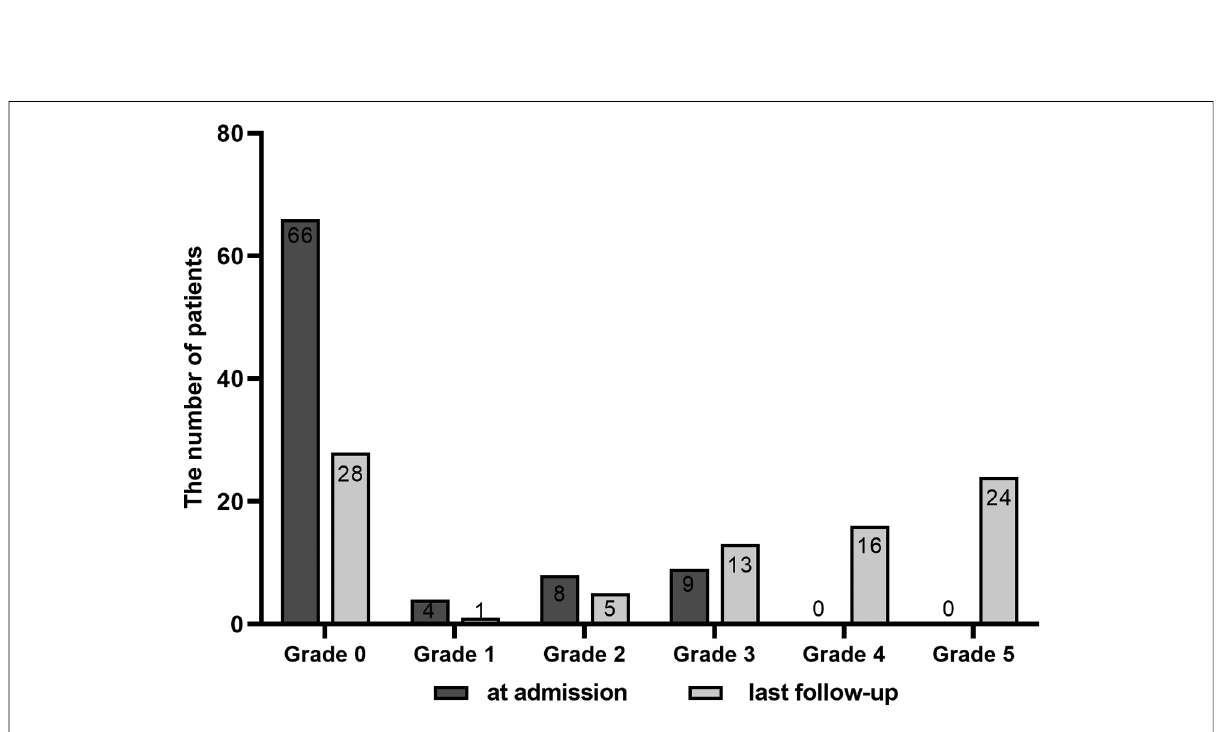
FIGURE 3 Comparison of muscle strength between pre-surgery (at admission) and last follow-up after